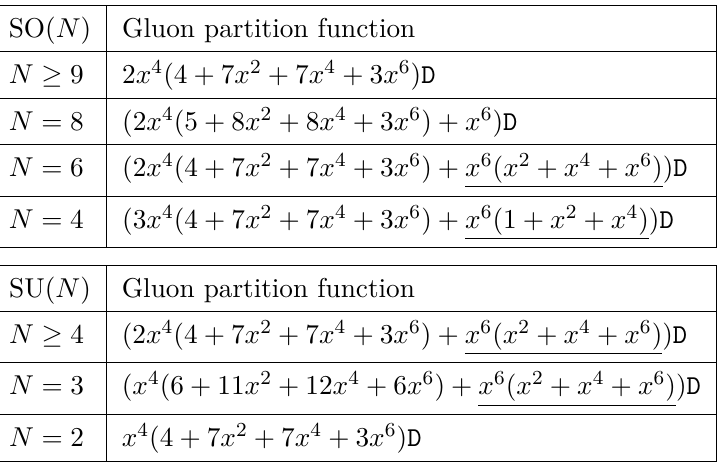
Table 4 . Partition function over the space of Lagrangians in D ≥ 8 involving four F a D ≡ 1 / ((1 − x 4 )(1 − x 6 )) . Contribution of M non-inv is underlined. The rest is the contribution